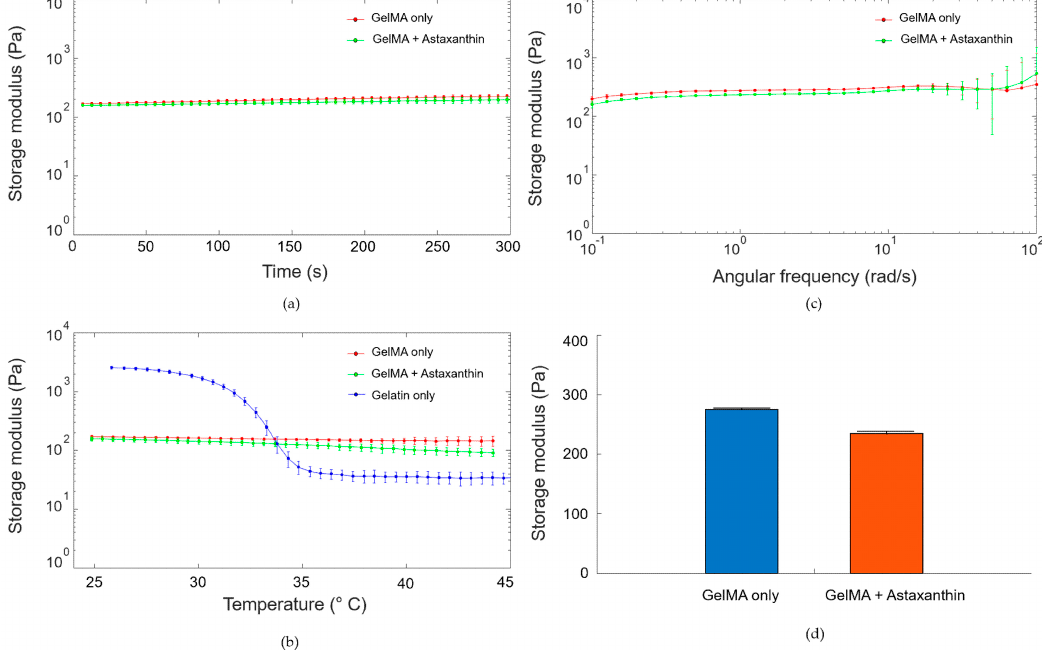
Figure 5. Rheological properties of GelMA with and without astaxanthin ( a ) time sweep test, ( b ) temperature ramp test, ( c ) frequency sweep test, and ( d ) the values of storage moduli (G’) at the frequency of 1 rad/s. Data are presented as the mean ± standard deviation (n = 3).